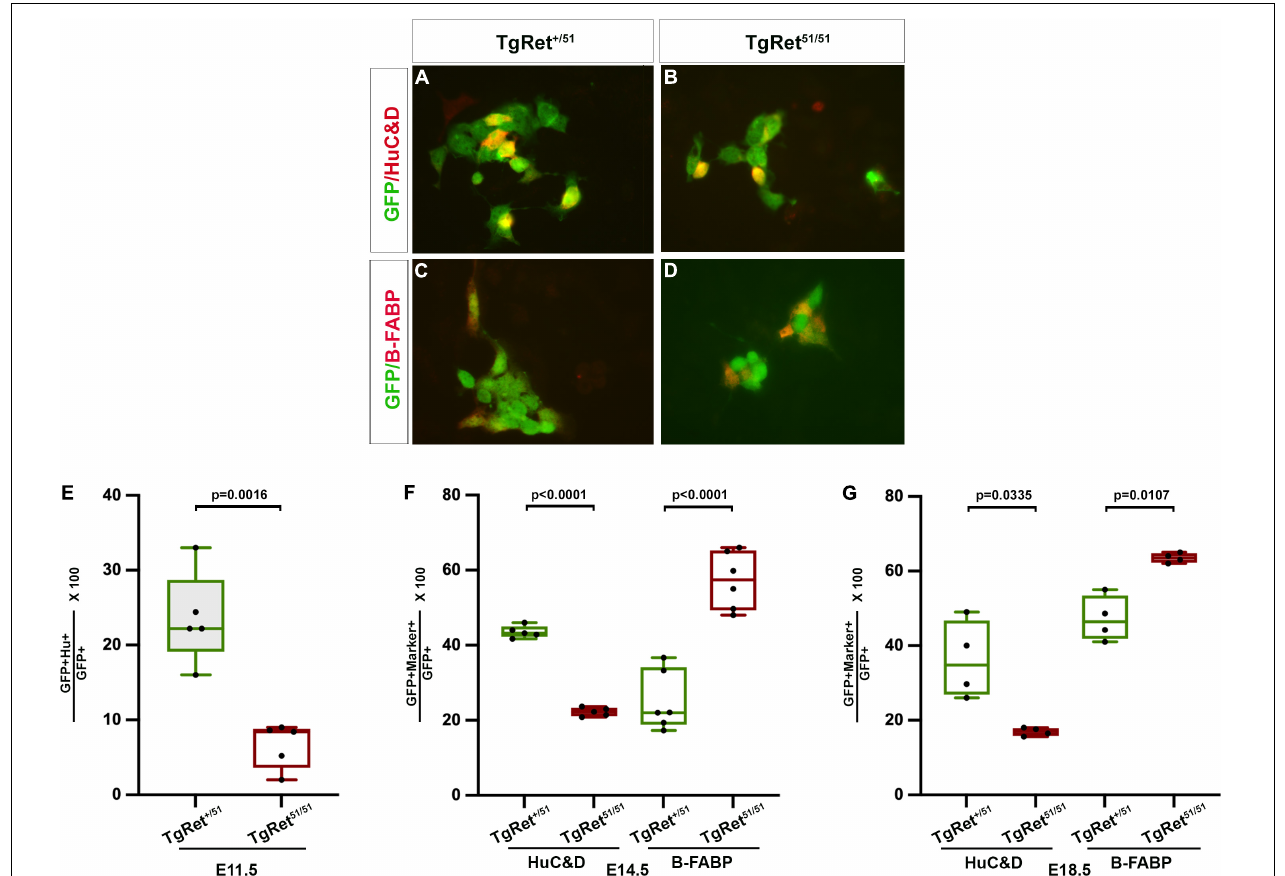
FIGURE 3 | Normal Ret activity is required for enteric neuron differentiation. (A,B) Short term cultures of dissociated gut from control Tg Ret + / 51 (A) and Tg Ret 51 / 51 (B) E11.5 embryos showing the co-expression of GFP (green) with a neuronal marker HuC/D (red). (C,D) Short term cultures of gut from control Tg Ret + / 51 (C) and Tg Ret 51 / 51 (D) E14.5 embryos showing co-expression of GFP (green) and a glial marker B-FABP (red). (E–G) Quantification of the percentage of GFP cells co-expressing either HuC/D or B-FABP at various time points. Graph showing percentage of GFP co-expressing HuC/D at E11.5 (E) . A significantly smaller fraction of Ret 51 / 51 GFP + cells have differentiated into neurons. Quantification of the percentage of GFP cells co-expressing HuC/D or B-FABP in short-term cultures of dissociated gut from control, Tg Ret + / 51 and Tg Ret 51 / 51 E14.5 embryos (F) . Quantification of percentage of GFP cells co-expressing HuC/D or B-FABP from whole mount of myenteric plexus of E18.5 (G) from control Tg Ret + / 51 and Tg Ret 51 / 51 embryos. Although the fraction of Ret 51 / 51 GFP + cells that have differentiated into neurons is reduced, the fraction expressing glial markers is increased at both E14.5 and E18.5. Embryos from 4 litters were used for analysis. Statistical analysis performed by Welch’s t -test. Tg Ret + / 51 represents cells or embryos from genotype Wnt1 cre / + ;R26R stop / YFP ;Ret + / 51 and Tg Ret 51 / 51 represents cells or embryos from genotype Wnt1 cre / + ;R26R stop / YFP ;Ret 51 / 51